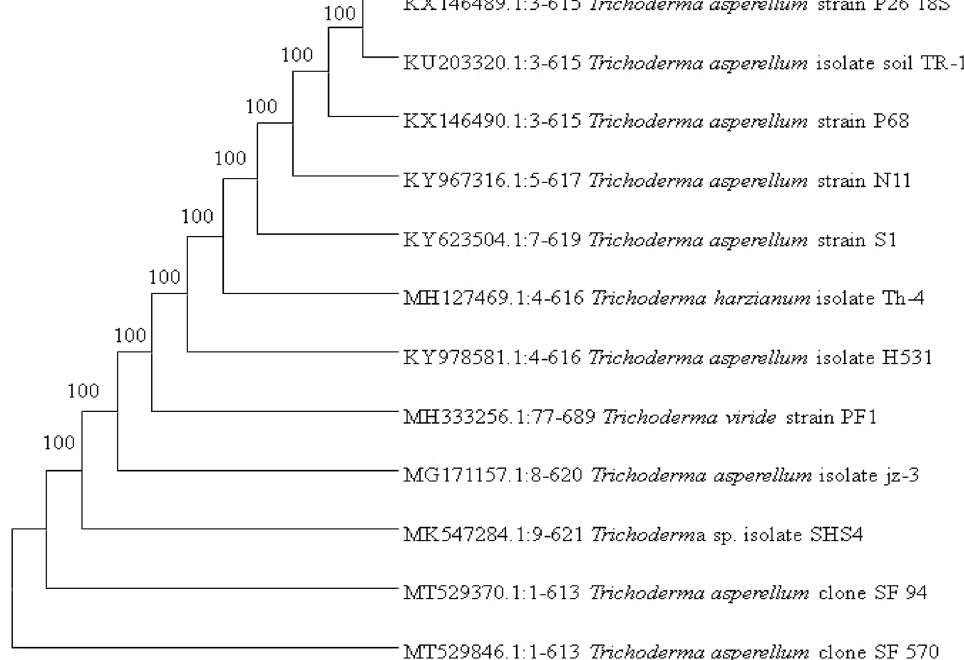
Figure 2. Phylogenetic tree of T. asperellum FbMi6 based on ITS-rDNA gene sequences. In-vitro efficacy of bio-agent.